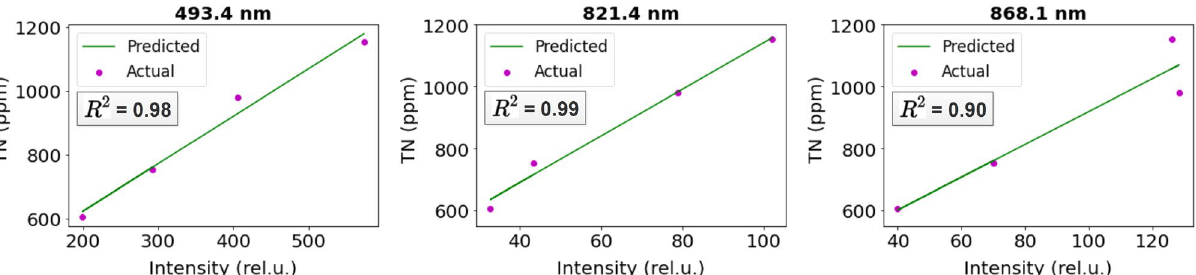
Figure 4. Calibration plot for computing soil TN using the peak intensity of the nitrogen spectrum at 493.4 nm, 821.4 nm, and 868.1